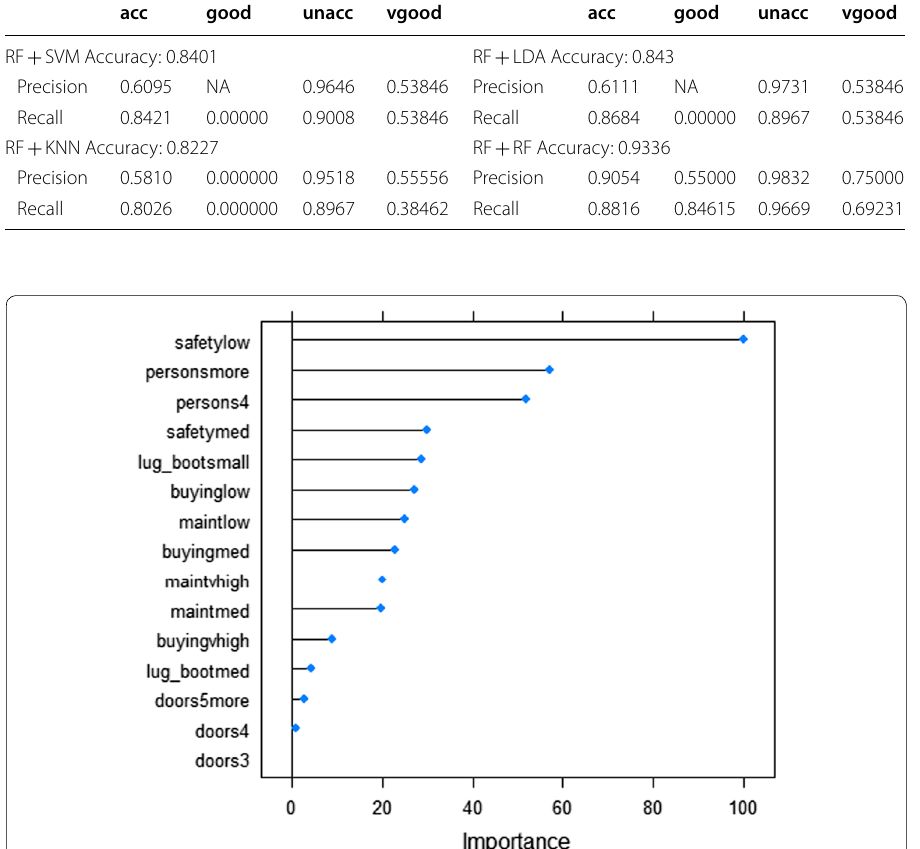
Fig. 6 The important measure for each variable of the Car Evaluation dataset using Random